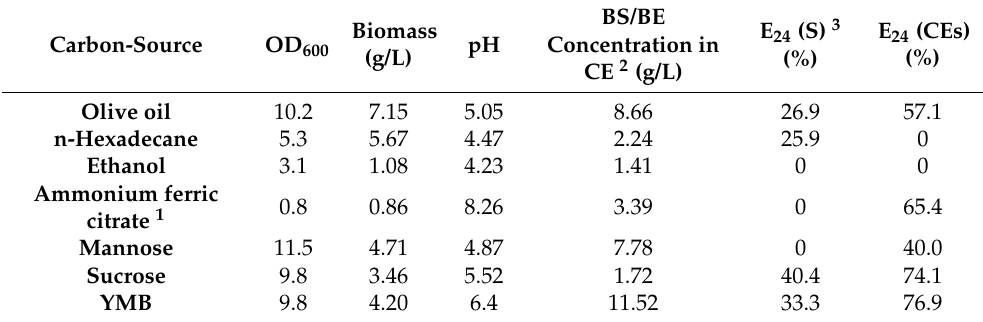
Table 1. Analytical parameters for the cultures and supernatants (S)/concentrated extracts (CEs) obtained in the growths with different